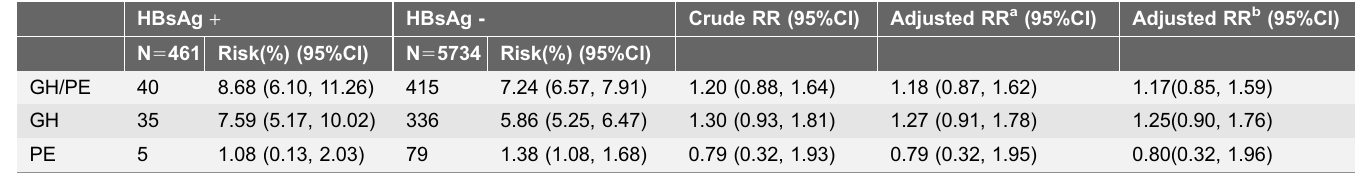
Table 3. Association between maternal HBV infection and pregnancy-induced hypertension, Liuyang, China, 2012. HBsAg